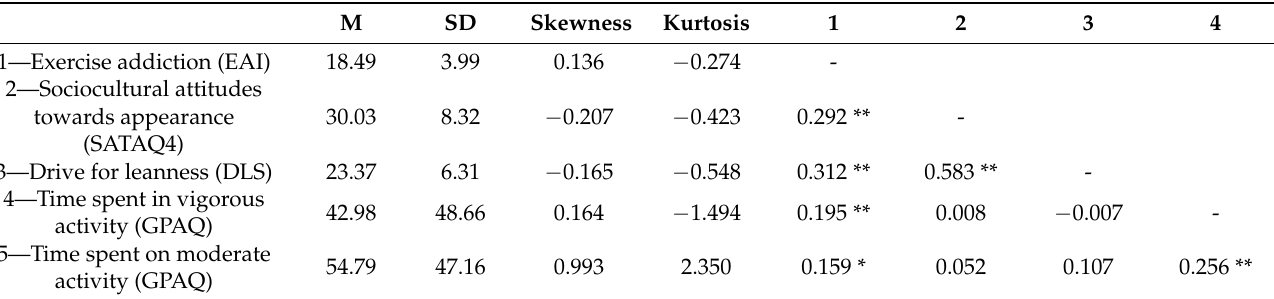
Table 2. Means, standard deviation, skewness, kurtosis, and